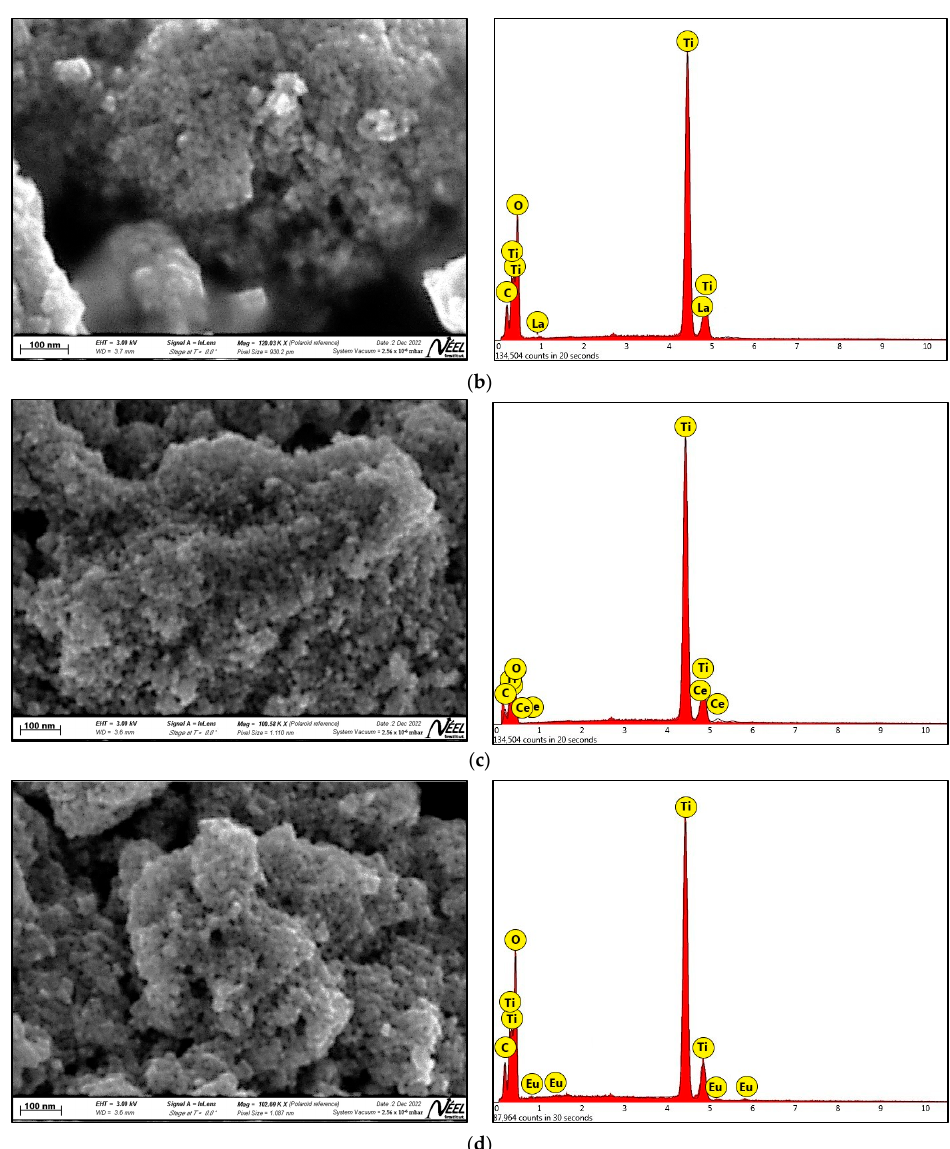
Figure 3. SEM images and EDS spectra of ( a ) TO, ( b ) La/TO, ( c ) Ce/TO, and ( d ) Eu/TO nanoparticles.